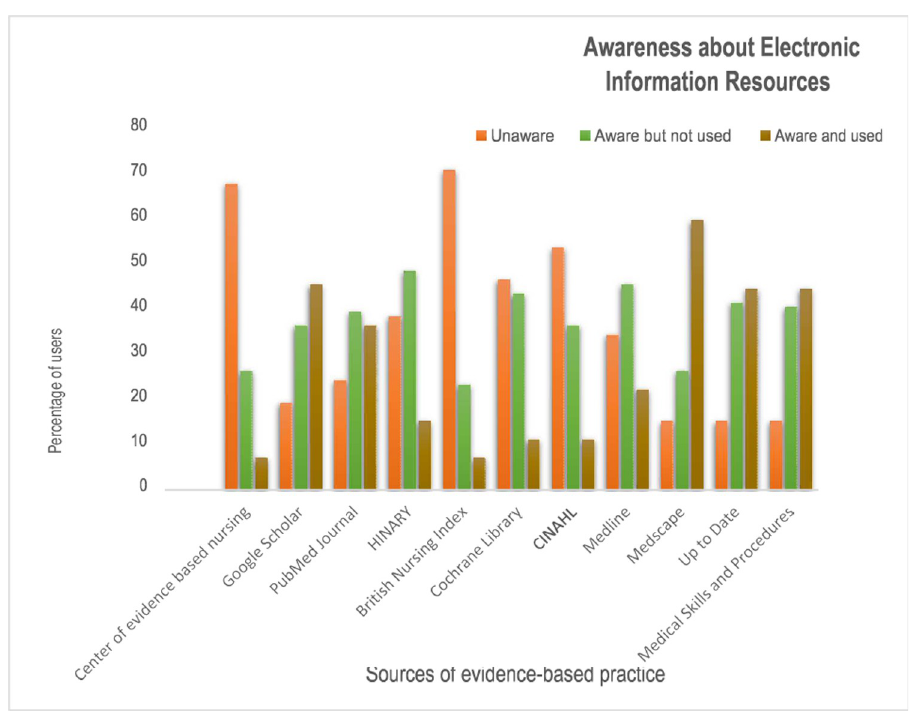
Fig 4. Awareness about electronic information sources of evidence-based practice among nurses in University of Gondar and Tibebe Gion teaching specialized hospitals, 2020 (n = 507).